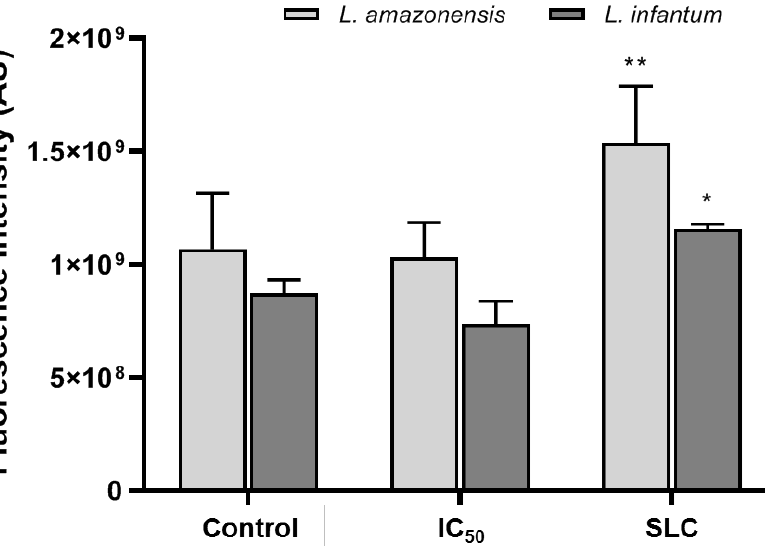
Figure 2. Effect of tryptanthrin on the mitochondrion membrane potential of Leishmania spp. Promastigote forms of L. amazonensis and L. infantum were treated with IC 50 (11 and 8.0 µ M, respectively) or SLC (63 µ M, for both parasite species). A statistical analysis of the differences between mean values obtained for the experimental groups was done by two-way ANOVA with Sidak’s multiple compar- isons test. Asterisks indicate treatment that was significantly different compared to the control, in which * p < 0.05 and ** p < 0.005. IC 50 , half-maximal inhibitory concentration; SLC, sub-leishmanicidal concentration